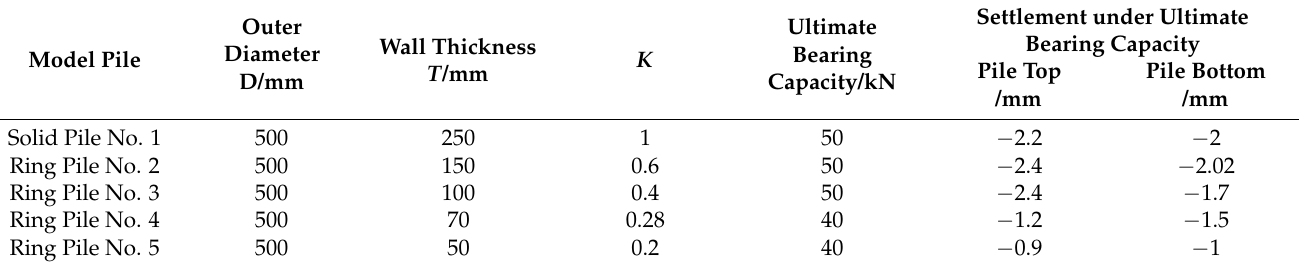
Table 2. Comparison of settlement of model piles.